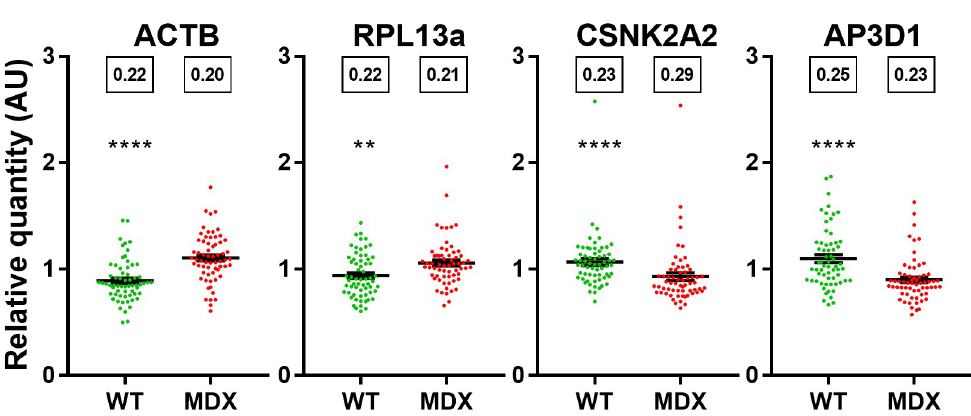
Fig 7. Expression of the four high scoring genes. Expression data for ACTB , RPL13a , CSNK2A2 and AP3D1 (as indicated) in all healthy and dystrophic samples, individually normalized to the geometric mean of ACTB , RPL13a , CSNK2A2 and AP3D1 . Data shown as individual sample relative quantity values (•) and means +/- SEM. �� :P < 0.01, ���� : P < 0.0001 (Mann-Whitney U test). Boxes: Coefficient of Variation.